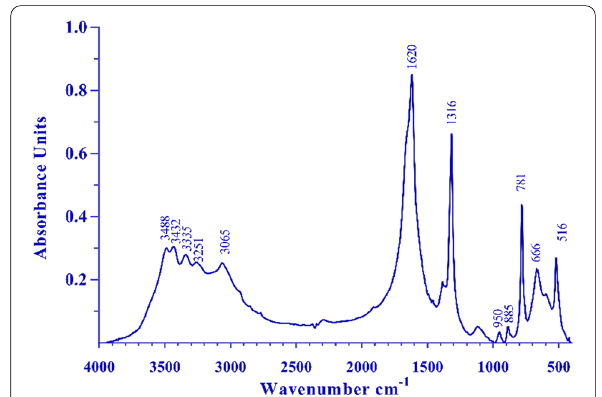
Fig. 1 Kidney stones of calcium oxalate